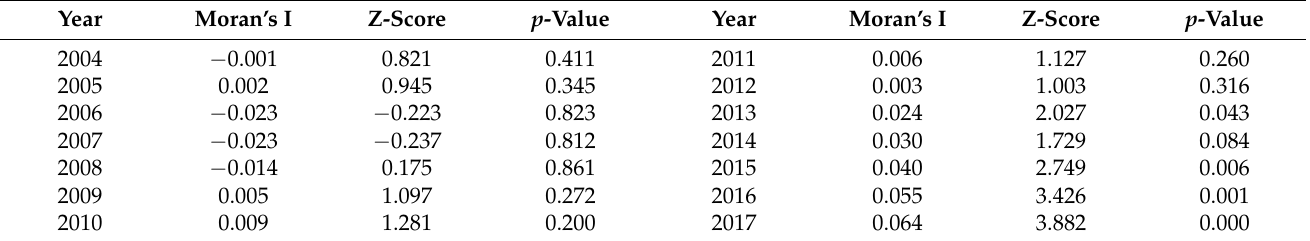
Table 3. Global Moran’s I values of YRB from 2004 to